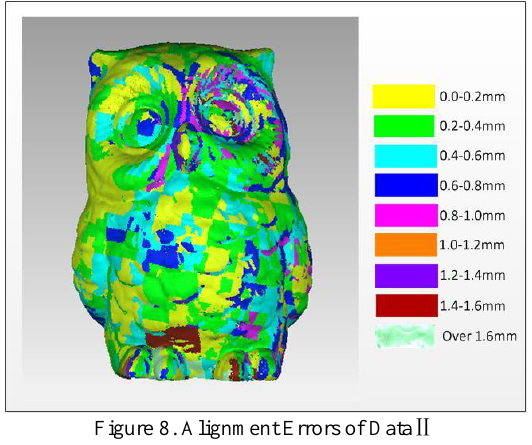
Figure 8. Alignment Errors of Data